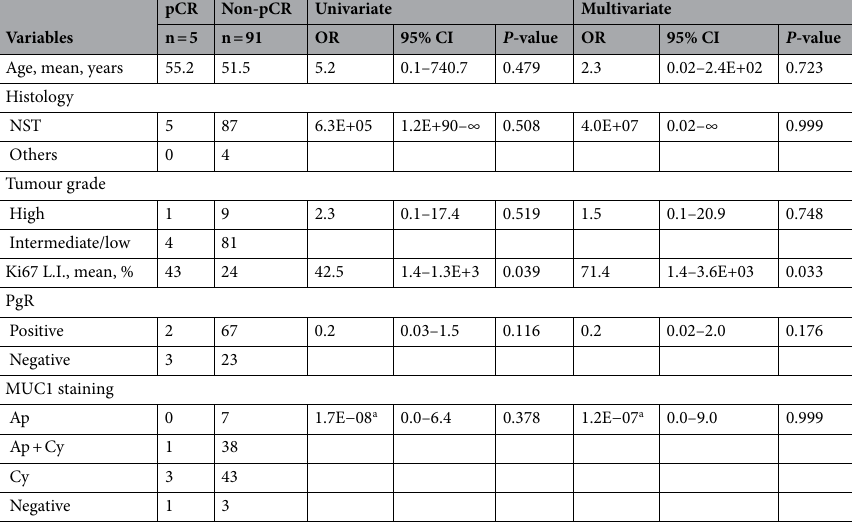
Table 1. Relationship between the effect of chemotherapy and clinicopathological features in the neoadjuvant chemotherapy cohort (n = 96). All biomarkers were assessed based on biopsy specimens. a Compared in two groups between Ap and other patterns. pCR pathological complete response, NST no special type, L.I. labelling index, PgR progesterone receptor, OR odds ratio, CI confidence interval, Ap apical, Cy